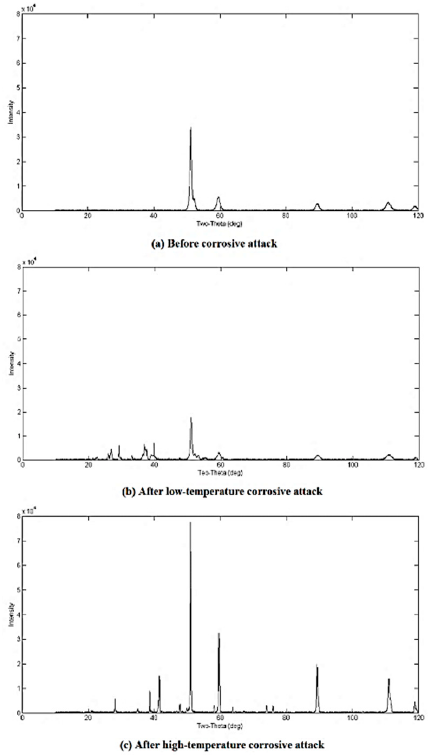
Figure A29. Qualitative XRD analysis of the surface of 316-Bare ( a ) before corrosive attack, ( b ) after low-, and ( c ) high-temperature corrosive attack.